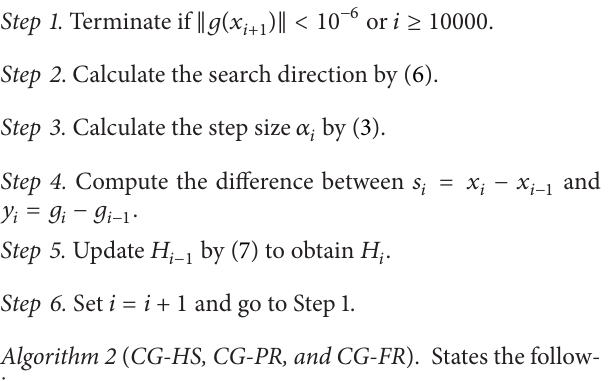
Algorithm 2 ( CG-HS, CG-PR, and CG-FR ). States the follow-